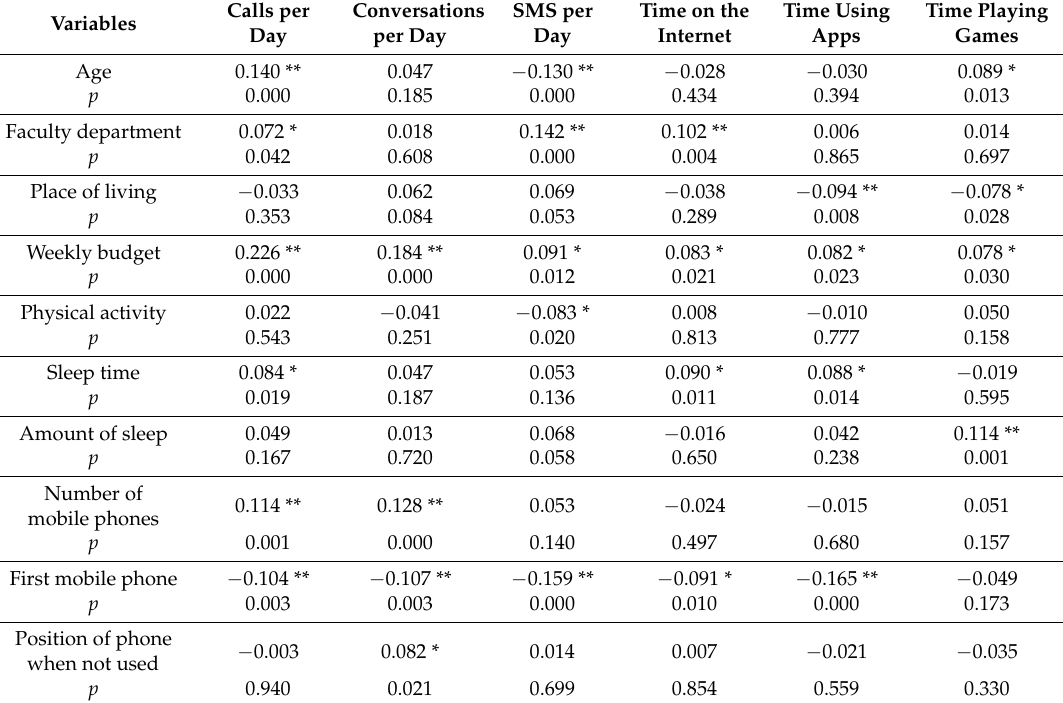
Table 3. Correlations between certain characteristics and cell phone use related habits.